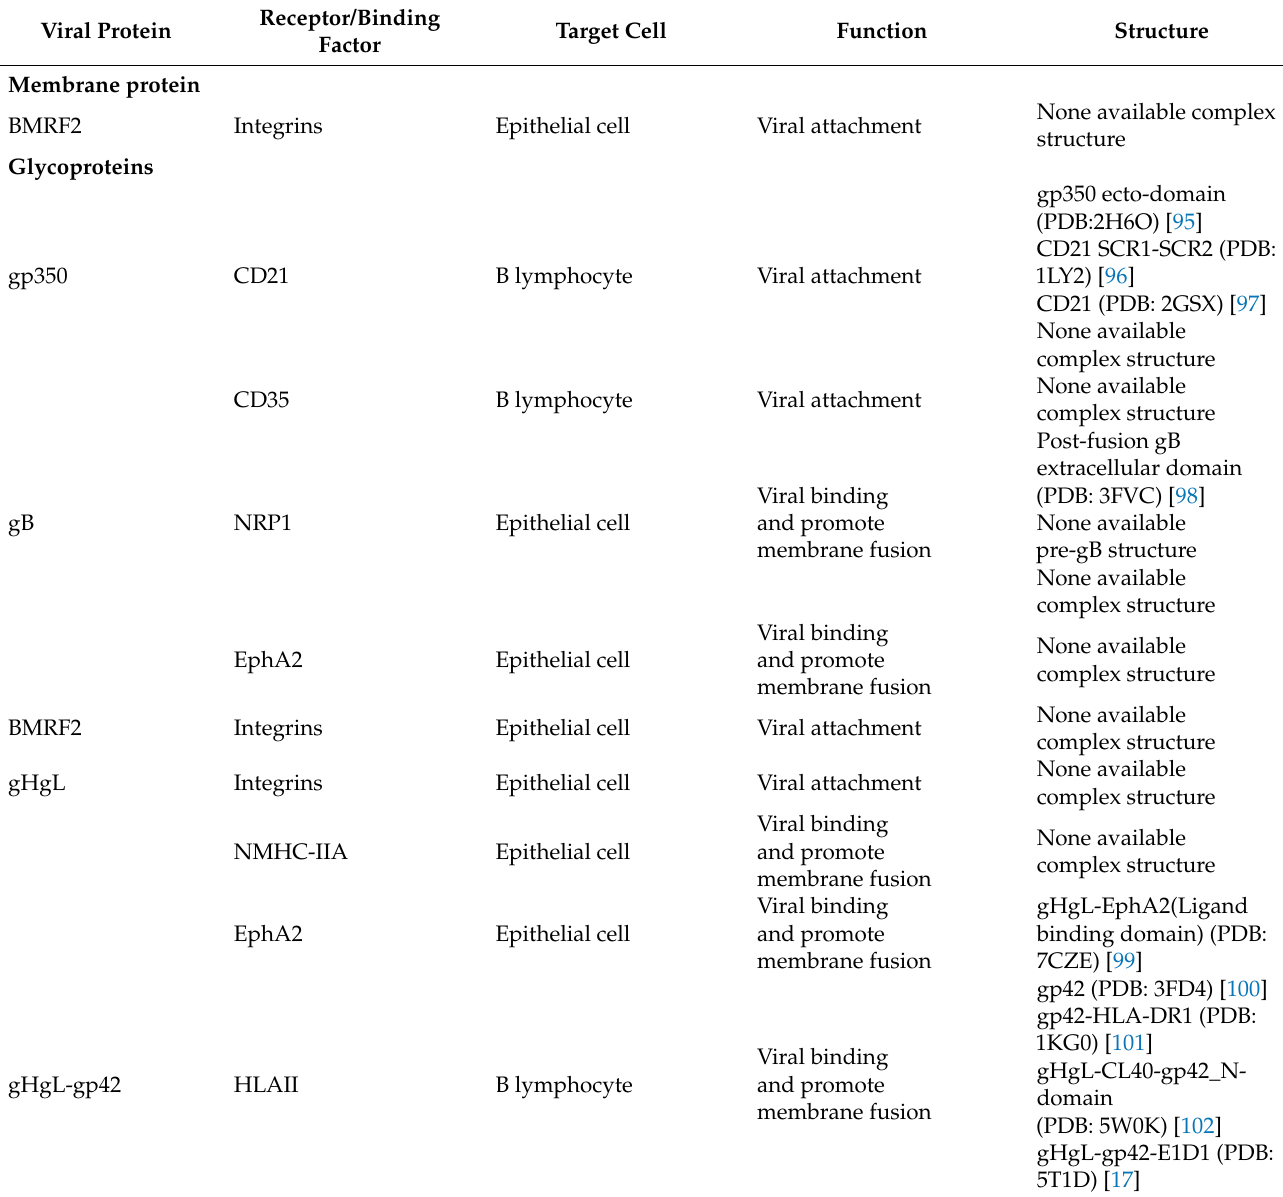
Table 1. Receptors/binding factors for EBV membrane